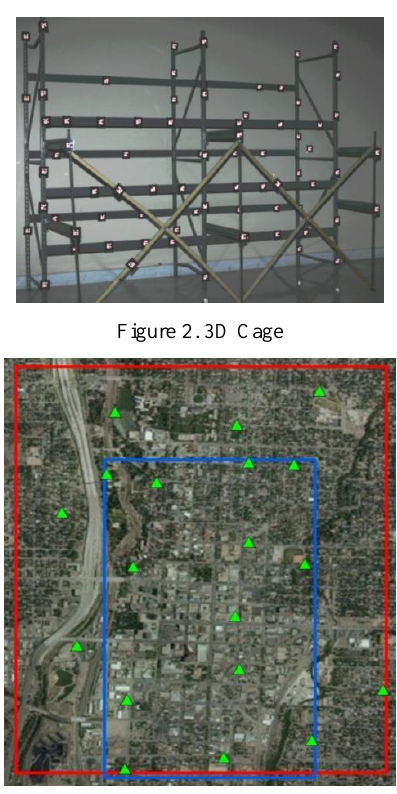
Figure 3- Boresight Flight Area, Downtown, Colorado Springs